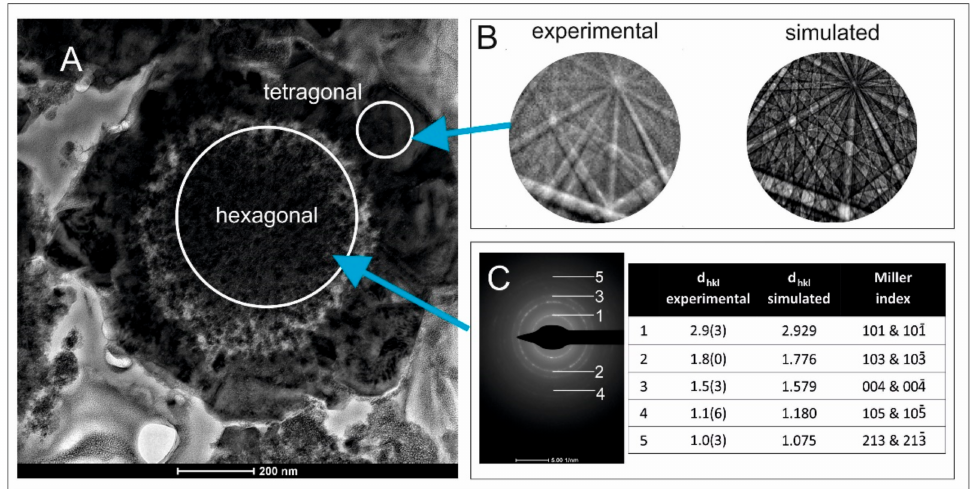
Figure 4. ( A ) TEM image of the concentric structure of a single CMTS_Tu microsphere. ( B ) Kikuchi diffraction patterns resulting from electron diffraction (EBSD) in the outer rim compared with those simulated for a relevant tetragonal structure. ( C ) Selected area diffraction pattern (TEM/SAED) resulting from electron diffraction in the inner core. A comparison between the measured and simulated d hkl values listed in the table indicated the hexagonal structure of the